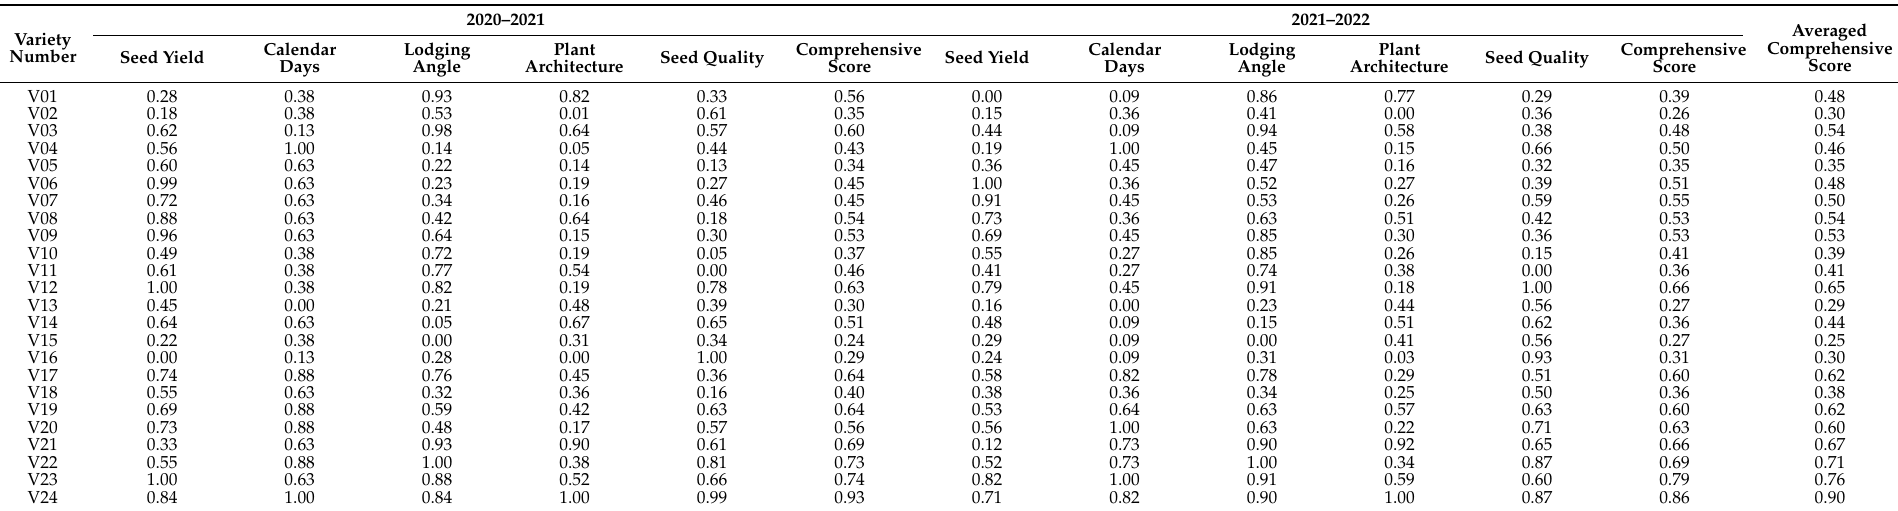
Table 4. Comprehensive scores for each indicator of the 24 tested varieties from the growing seasons of 2020–2021 and 2021–2022. Variety